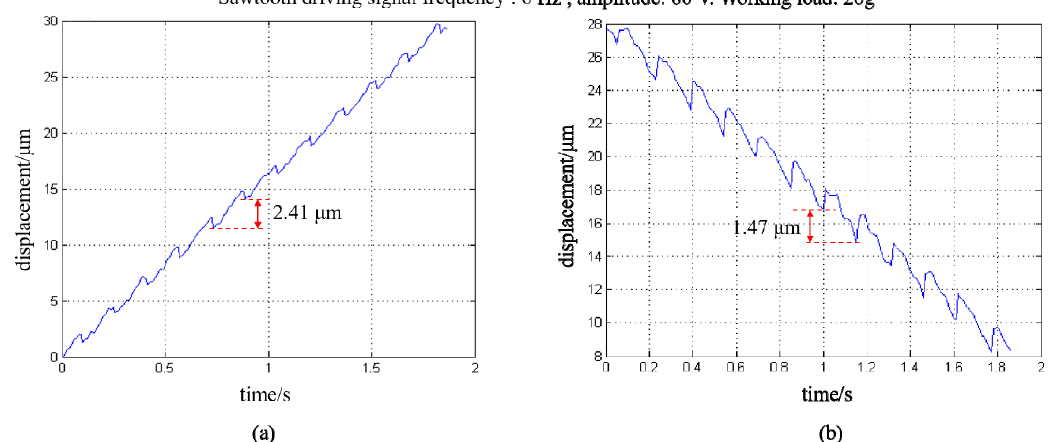
Figure 14. Forward and backward displacement of the stage with working load of 20 g: ( a ) forward movement; ( b ) backward movement.